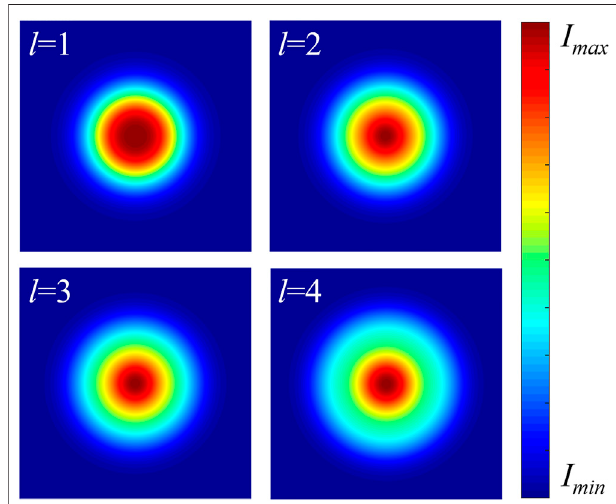
FIGURE 2 | Light intensity distribution within the orbital polarization holographic recording fi eld when the value of TC increases from 1 to 4. The totalintensitiesoftheinterference fi eldsarethesumoftheintensitiesofthetwo recording beams without interference